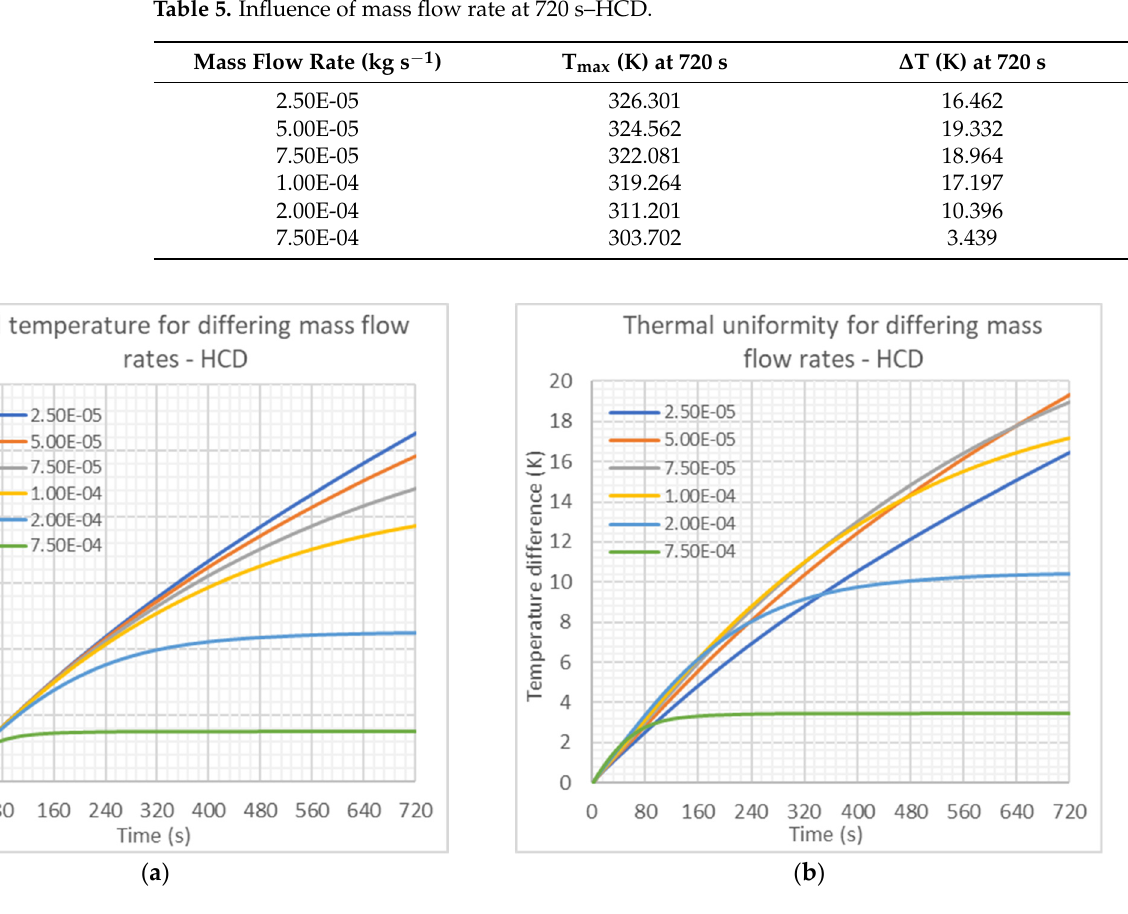
Figure 11. LCD contours: ( a ) Cell temperature (K); ( b ) Fluid pathlines.